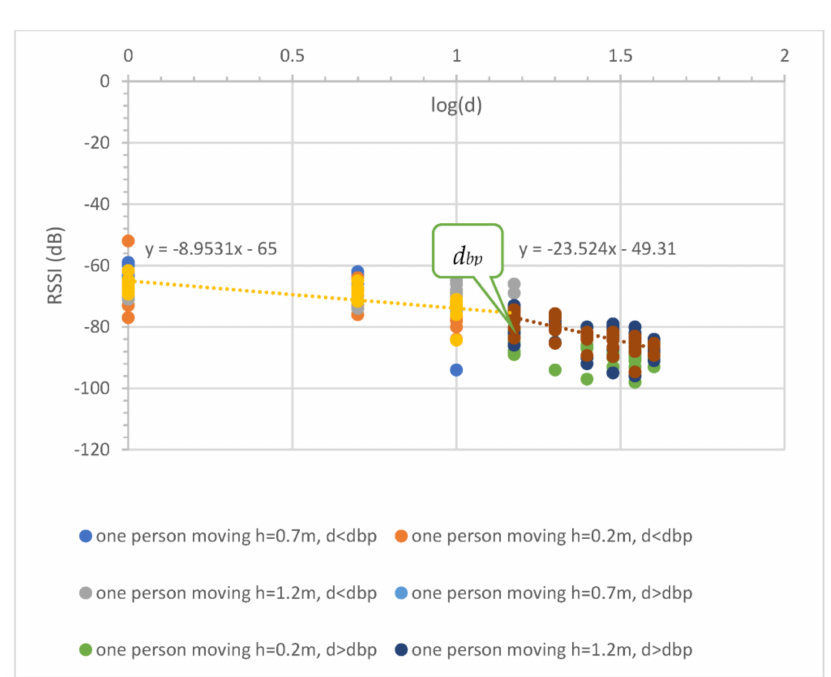
Figure 7. Uncertainty in observed RSSI and distance with one person (farmer) moving, for all antenna heights.